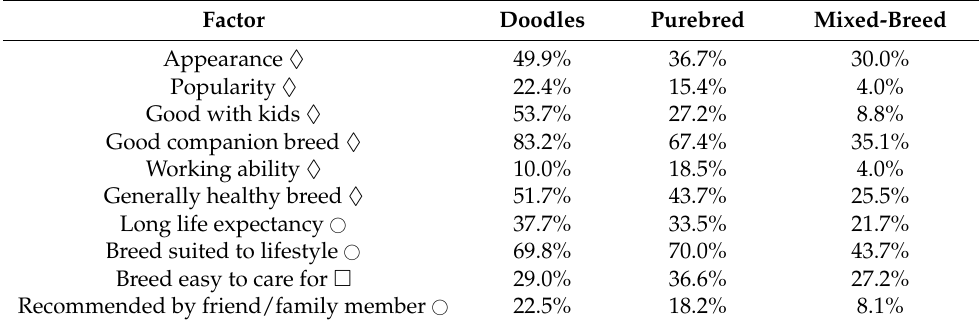
Table 3. Factors that influenced people to acquire their dog type, with percentages of each group of dog owners that listed each factor as influential. ♦ denotes that each group differed significantly from the others; denotes significant differences between mixed breeds and doodles and between (cid:35) mixed breeds and purebreds; and (cid:3) denotes significant differences between purebreds and doodles and between purebreds and mixed breeds. Factor Doodles Purebred Mixed-Breed Appearance ♦